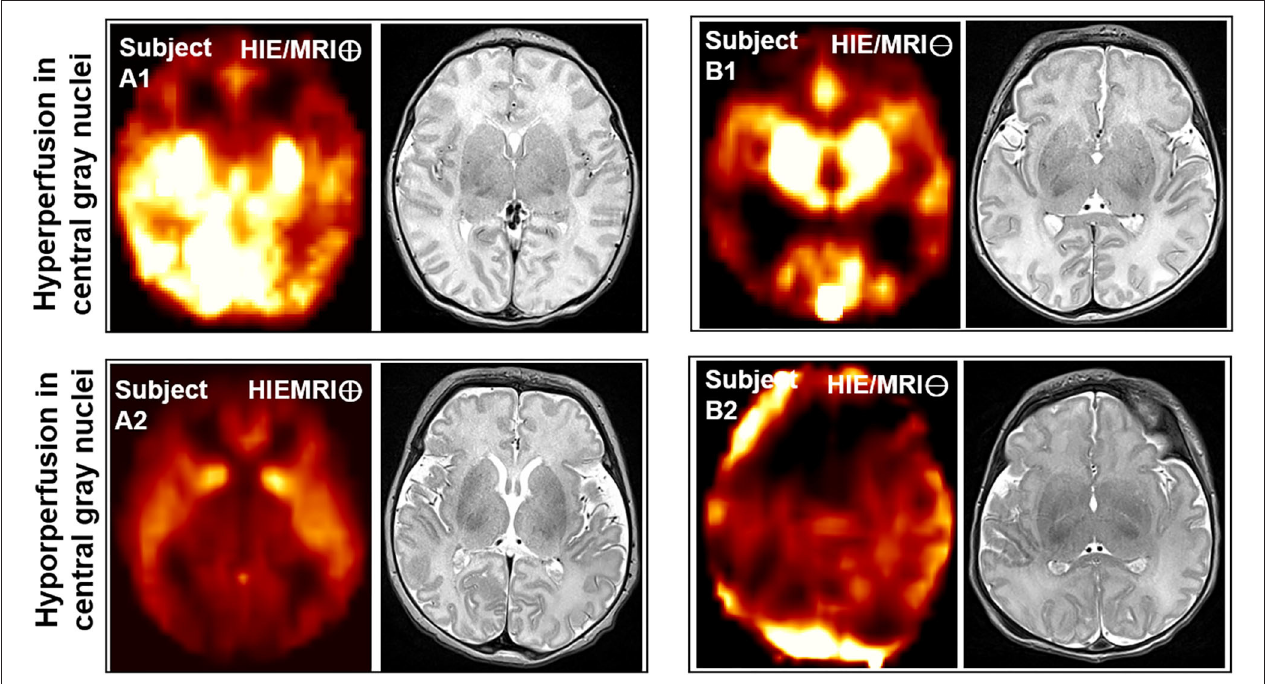
FIGURE 3 | Axial views of CBF map and T2WI image comparison of different HIE patients with good and poor outcome in the 1st and 2nd rows. Subject A1 is from HIE/MRI ⊕ group, having hyperperfusion in those vital brain structures and Bayley-III scores of cognitive = 105( > 80), language = 112( > 80), and motor = 97( > 80); Subject A2 is from HIE/MRI ⊖ group, having hypoperfusion in those vital brain structures and Bayley-III scores of cognitive = 75( < 80), language = 71( < 80), and motor = 76( < 80); Subject B1 is from HIE/MRI ⊕ group, having hyperperfusion in those vital brain structures and Bayley-III scores of cognitive = 105( > 80), language = 91( > 80), and motor = 97( > 80); Subject B2 is from HIE/MRI ⊖ group, having hypoperfusion in those vital brain structures and Bayley-III scores of cognitive = 55( < 80), language = 47( < 80), and motor = 46( < 80). The vital brain structures refer to cerebellum, brainstem and deep structures such as the thalamus, putamen, and the globus